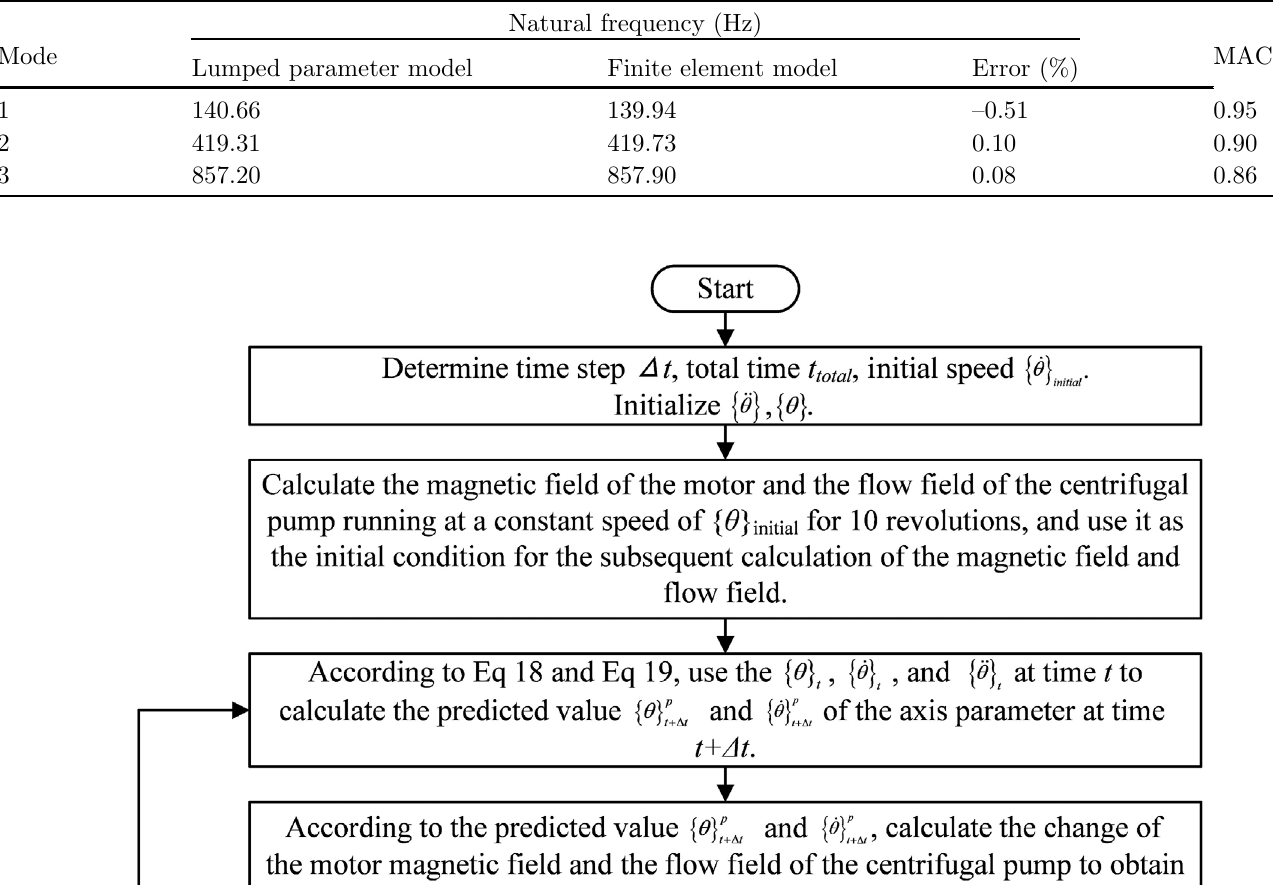
Table 5. Modal calculation result.